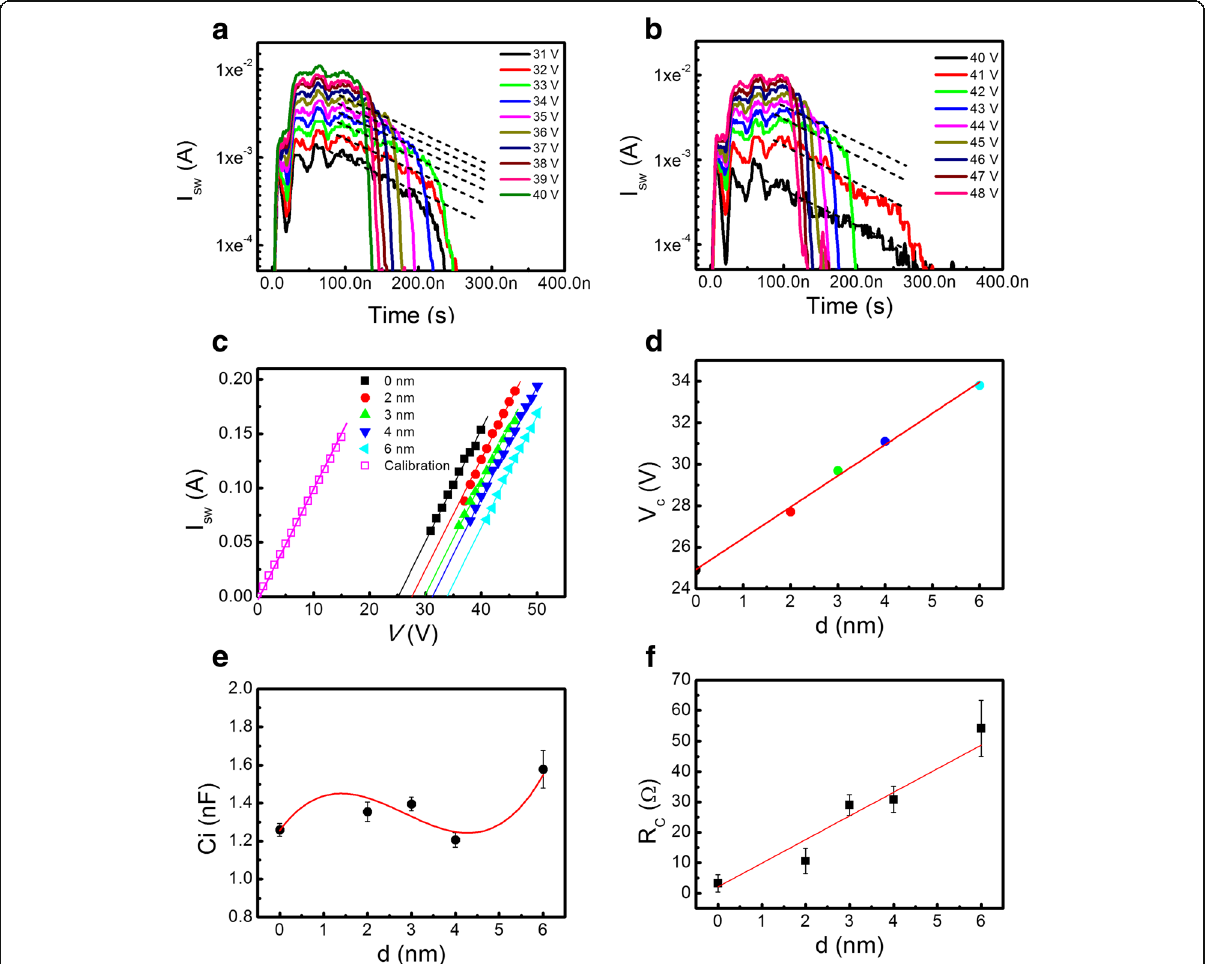
Fig. 3 a , b I sw - t dependences in type I under different V applied to the Al 2 O 3 /LN bilayer with the Al 2 O 3 thickness d = 0 and 6 nm, respectively, fitted by a series of parallel dotted lines to Eq. (1). c The plateaus of domain switching current as a function of the applied voltage with different Al 2 O 3 layer thicknesses, where the solid lines show the best fit of the data to Eq. (2). d The Al 2 O 3 -layer-thickness d dependence of the coercive voltage ( V c ) extracted from c . e , f The extracted interfacial capacitance C i and contact resistance R C as functions of the Al 2 O 3 layer thickness d